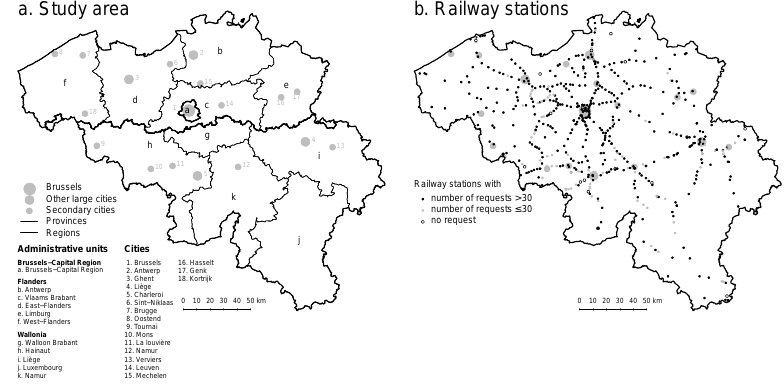
Figure 2. ( a ) Administrative and urban structure of Belgium; and ( b ) location of the train